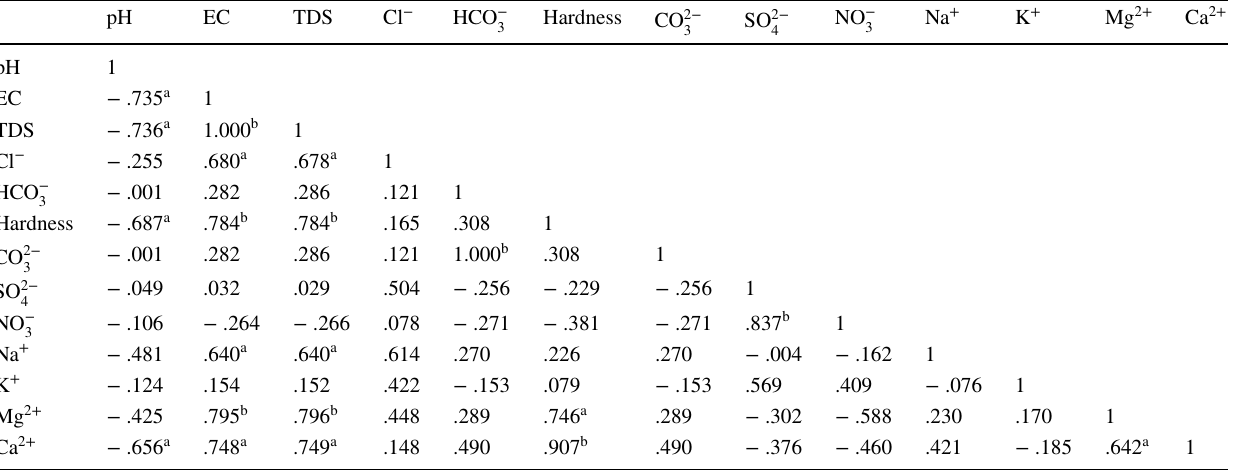
a Correlation is significant at the .05 level (2-tailed) b Correlation is significant at the .01 level Table 5 Correlation coefficient of water samples parameters during wet season